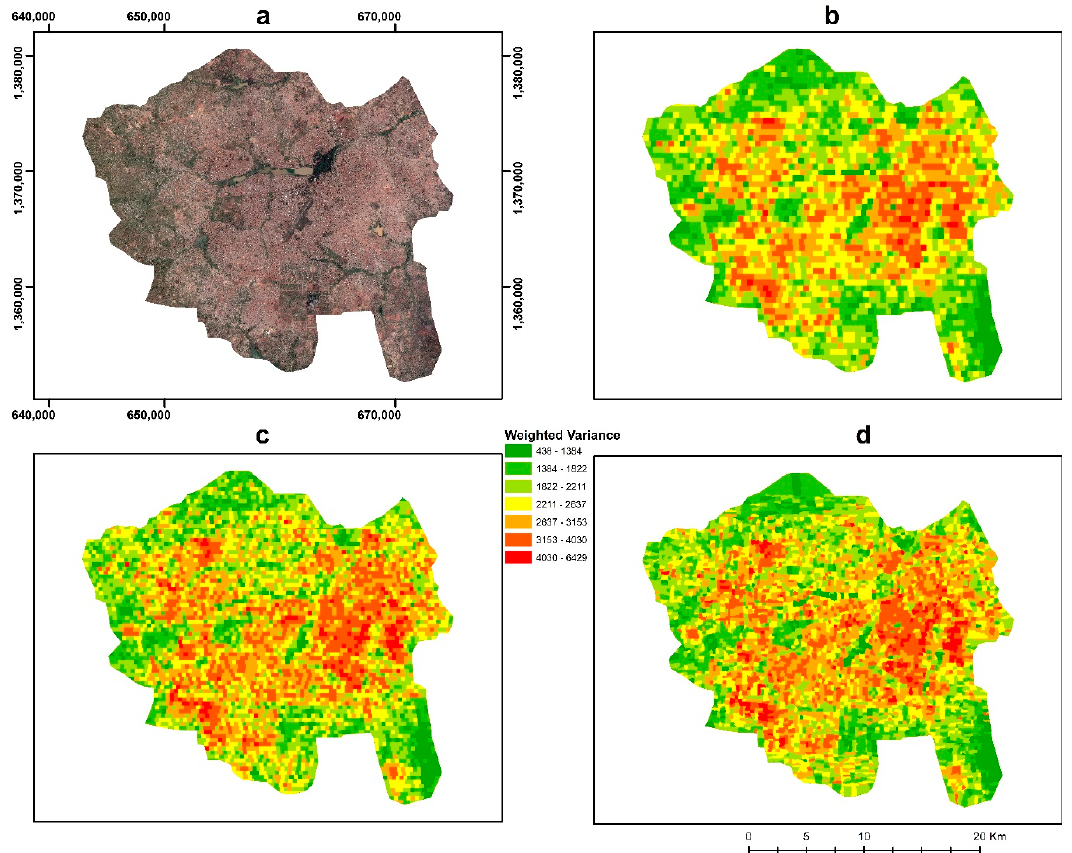
Figure 6. Spatial variation of weighted variance (WV) across Ouagadougou. ( a ) WorldView-3 RGB composite, partitioning by ( b ) P1, ( c ) P2 and ( d ) P3 approaches, respectively. High values of WV indicate large intra-segment variability while low values describe more homogenous objects.